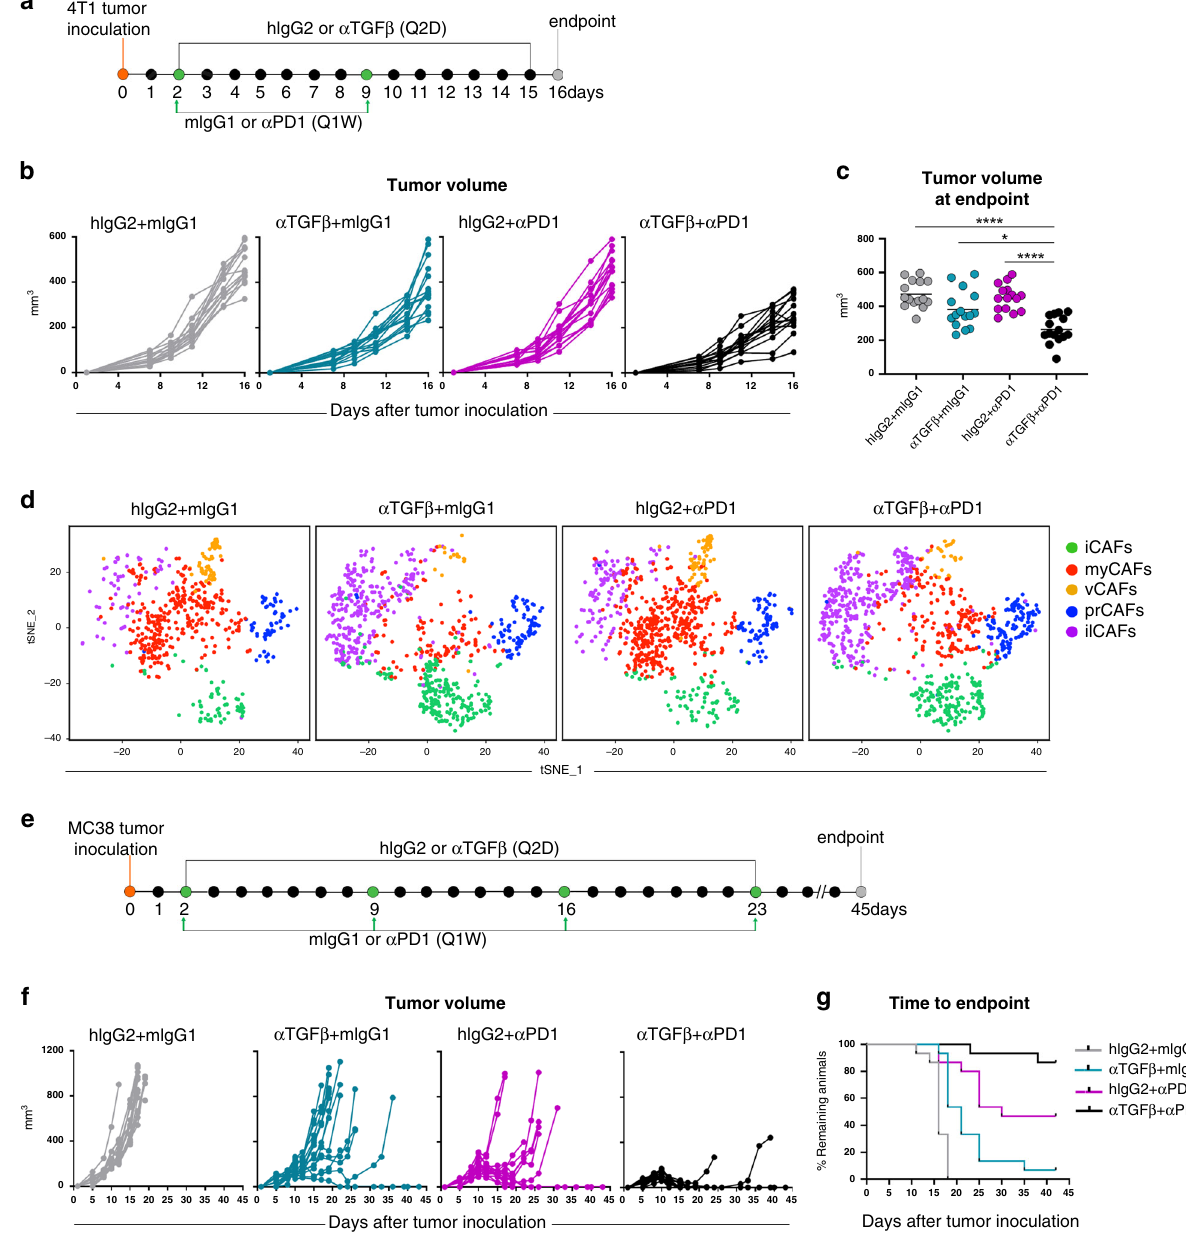
Fig. 7 TGF β -blockade augments the ef fi cacy of PD1 immunotherapy. a Study schematic of TGF β /PD1 co-blockade in 4T1 tumor bearing mice. b Individual 4T1 tumor volumes for animals treated as in a were determined by measurement with calipers. Each line represents a mouse. n = 15 mice per group. Data are representative of four independent experiments. c 4T1 tumor volumes measured at endpoint, each dot represents a mouse. Mean is depicted. n = 15 mice per group. Data are representative of four independent experiments. p -values were calculated using Brown-Forsythe and Welch ANOVA with Dunnett ’ s T3 multiple comparisons test, and individual values are as follows: hIgG2 + mIgG1 vs α TGF β + mIgG1, p = 0.0883; hIgG2 + mIgG1 vs hIgG2 + α PD1, p = 0.9768; hIgG2 + mIgG1 vs α TGF β + α PD1, **** p < 0.0001; α TGF β + mIgG1 vs α TGF β + α PD1, * p = 0.0155; hIgG2 + α PD1 vs α TGF β + α PD1, **** p < 0.0001. d t-SNE plots of CAF subsets separated by treatment group. n = 4 mice per group from two independent experiments. e Study schematic of TGF β /PD1 co-blockade in MC38 tumor bearing mice. f Individual MC38 tumor volumes for animals treated as in e were determined by measurement with calipers. Each line represents a mouse. g Mice treated as in e were removed from study when tumors reached 900 mm 3 , and the fraction of animals remaining on study was depicted using a Kaplan-Meier curve. One representative of 4 experiments is shown in f and g , n = 15 mice per group per